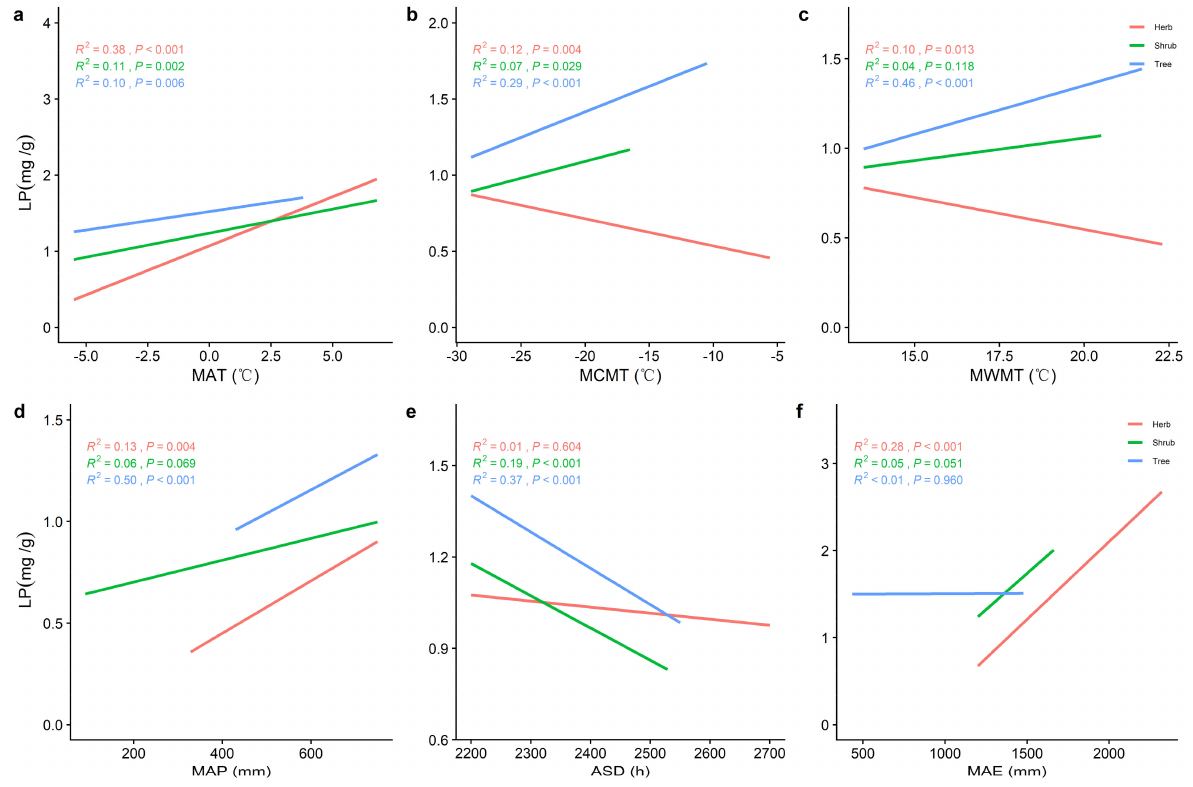
Figure 4. The general linear correlation analysis of climate factors with LP at different life forms. ( a ) General linear relationship between the MAT and LP of plants in the trees, shrubs, and herbs. ( b ) General linear relationship between the MCMT and LP of plants in the trees, shrubs, and herbs. ( c ) General linear relationship between the MWMT and LP of plants in the trees, shrubs, and herbs. ( d ) General linear relationship between the MAP and LP of plants in the trees, shrubs, and herbs. ( e ) General linear relationship between the ASD and LP of plants in the trees, shrubs, and herbs. ( f ) General linear relationship between the MAE and LP of plants in the trees, shrubs, and herbs. MAT represents the mean annual temperature, MCMT represents the mean coldest monthly temperature, MWMT represents the mean warmest monthly temperature, MAP represents the mean annual precipitation, ASD represents the annual sunlight duration, and MAE represents the mean annual evaporation. The red line represents the tree level, the green line is the shrub level, and the blue line is the herb level. R 2 represents how well the model fits the variables studied and the p -value represents the significance